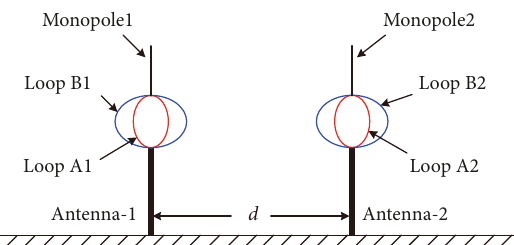
Figure 1: Diagram of a dual CLM antenna array, where monopole, loop B, and loop A are the three elements of the single CLM antenna, and d is the spacing between two CLM